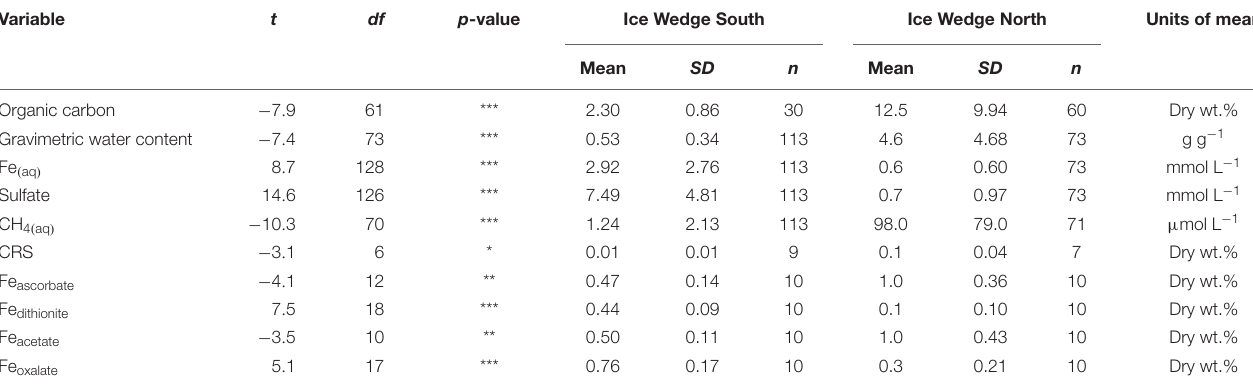
TABLE 2 | Results of Welch’s t -tests comparing organic carbon, gravimetric water content, Fe ( aq ) , sulfate, CH 4 ( aq ) , CRS, Fe ascorbate , Fe dithionite , Fe acetate , and Fe oxalate for Ice Wedge South and Ice Wedge North. Variable t df p -value Ice Wedge South Ice Wedge